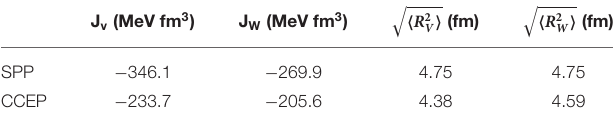
TABLE 2 | Volume integrals per interacting pair and root mean square radii for the real (V) part and imaginary (W) part of the São Paulo potential (SPP) and coupled channel equivalent polarization potential (CCEP) optical potentials adopted in the